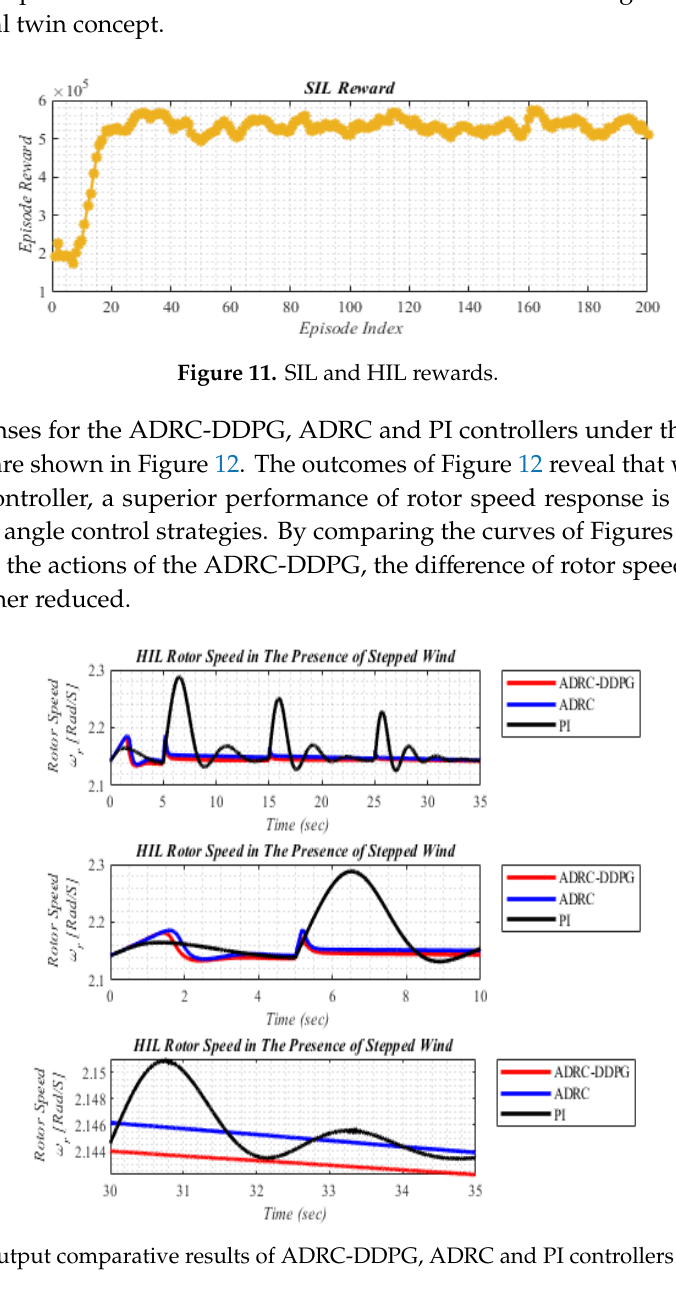
Table 1. Settling time, overshoot and output error comparison outcomes according to the scenario I.